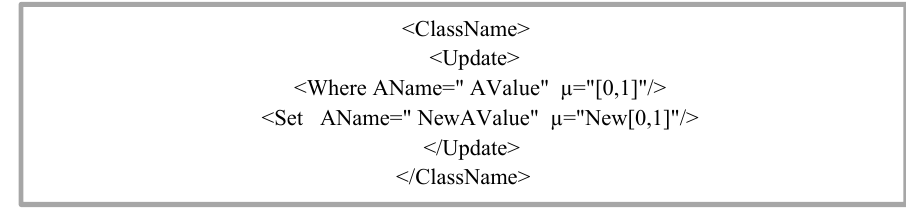
Fig. 3. Update Syntax with XML tags